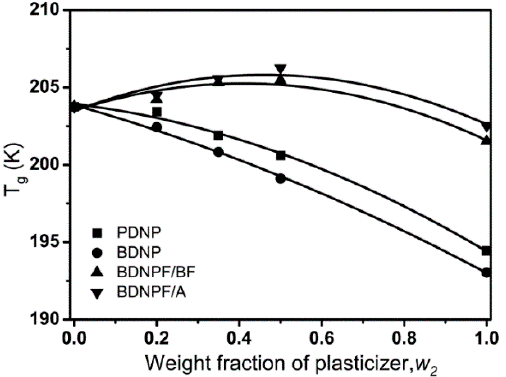
Figure 1. T g variation of binary mixtures of PGT prepolymer/REPs as a function of the REP content.